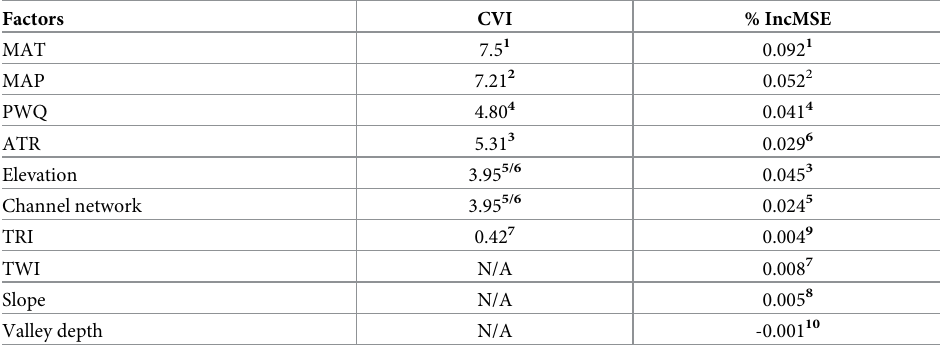
Table 3. Factor importances to CART and RF model